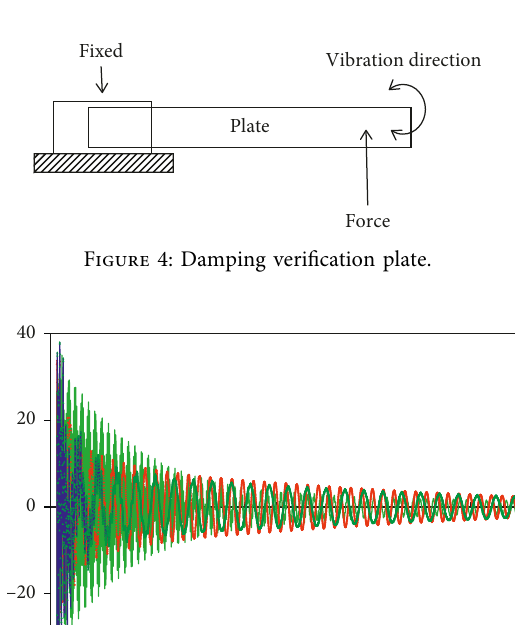
Figure 3: Magnesium alloy wheel. (a) 3D model. (b) FE model.